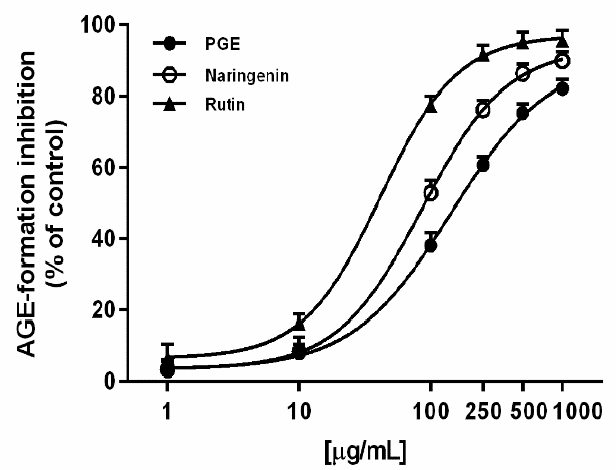
Figure 5. AGE inhibition by the ethyl acetate extract, obtained by Soxhlet from the waste peel of Punica granatum L. var. Dente di Cavallo DC2 (PGE), rutin, and the positive control naringenin. Each value represents mean ± SEM ( n = 4).